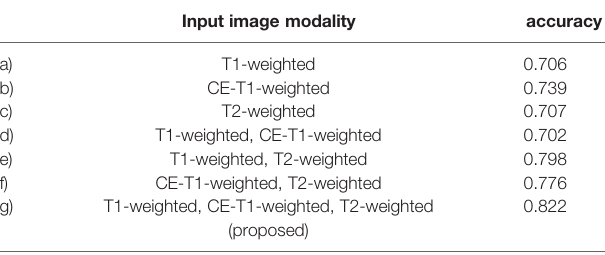
TABLE 3 | Comparison of the accuracy for different channel compositions in asingle MR slice.